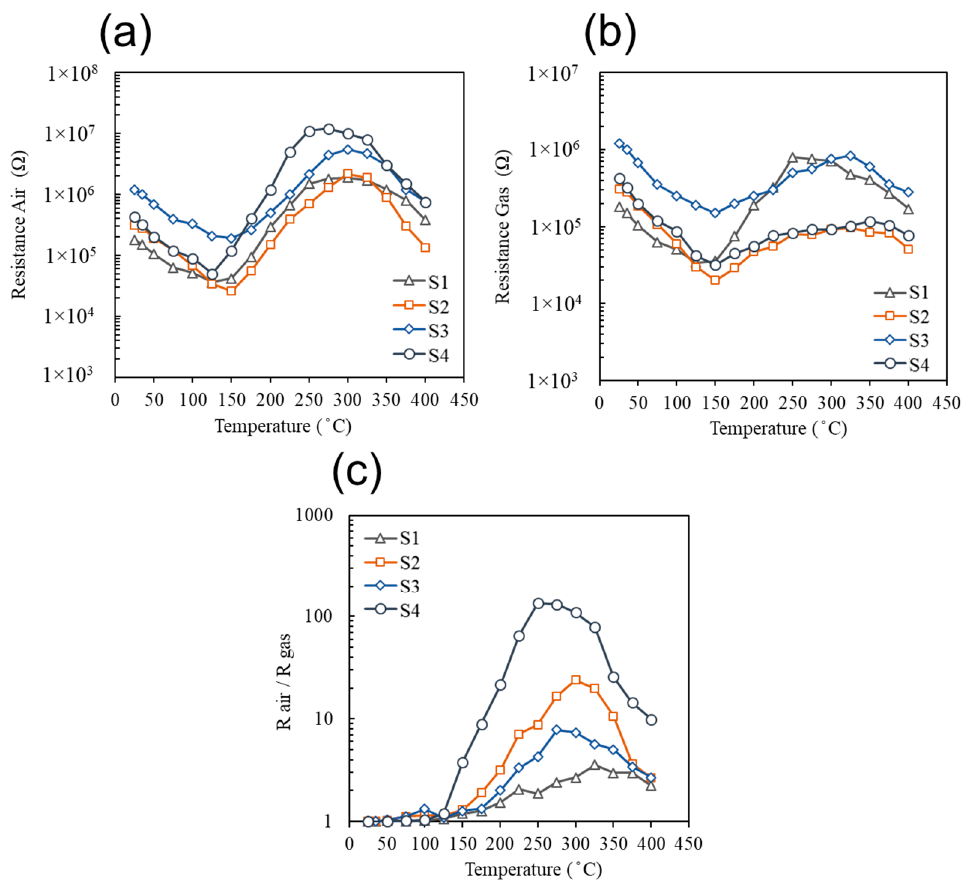
Figure 15. ( a ) Baseline resistances of the sensors S1–S4 in ultra-zero grade air, ( b ) the corresponding resistances of sensors S1–S4 in the presence of 0.5 ppm of benzene, and ( c ) the calculated responses of sensors S1–S4 to 0.5 ppm of benzene over the temperature range from 25 to 400 °C.